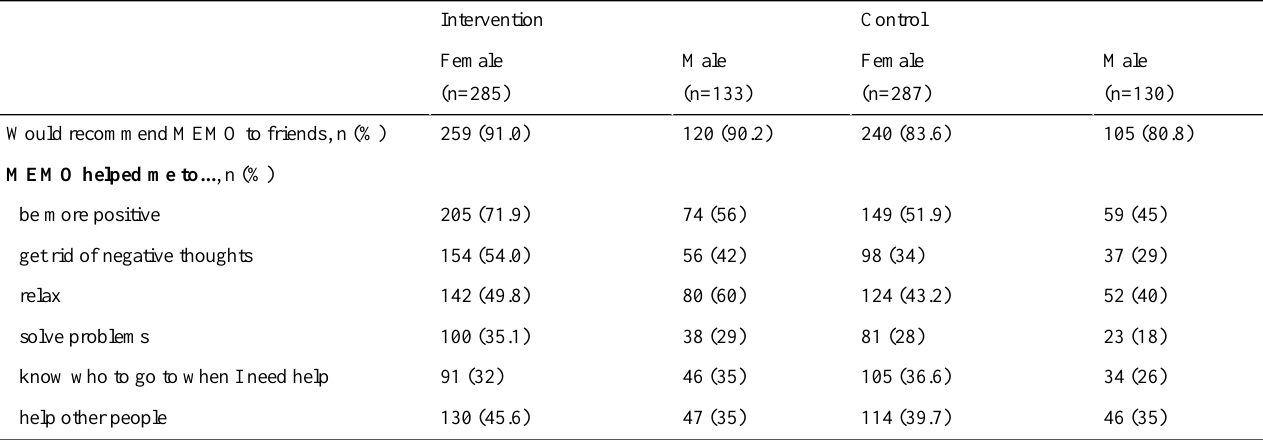
Table 4. Perceived usefulness by sex